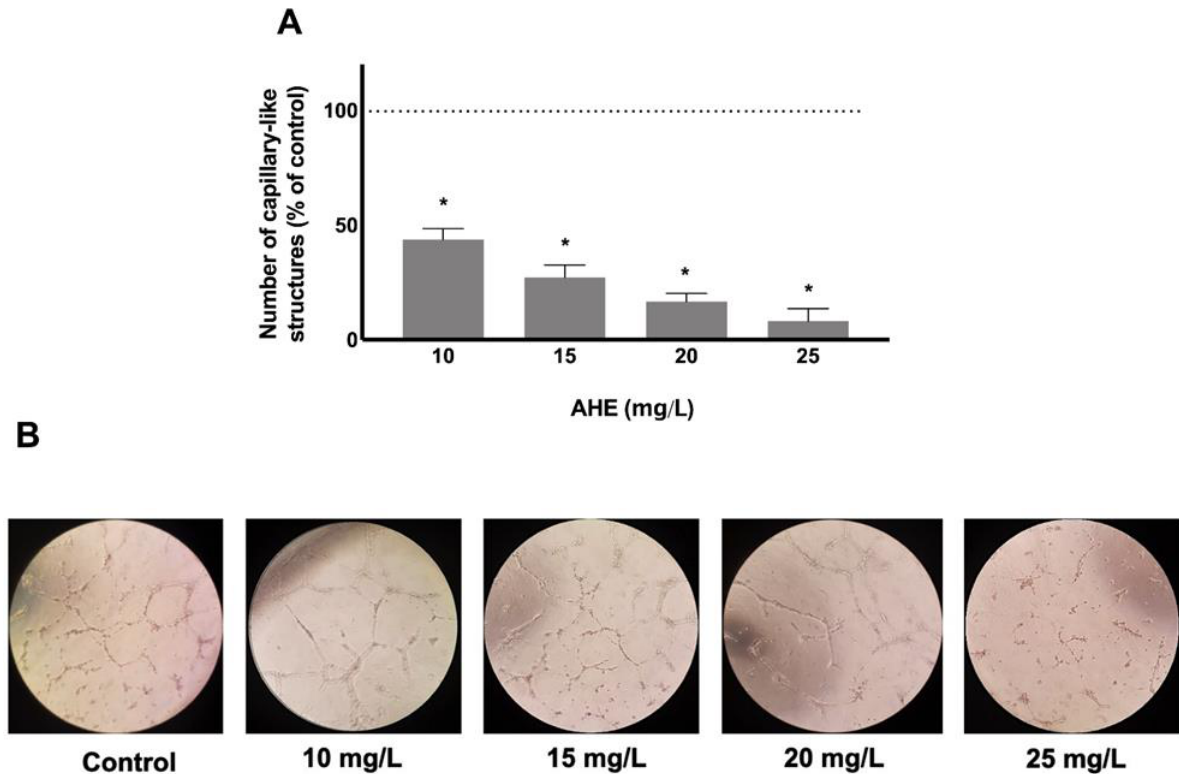
Figure 4. Formation of capillary-like structures was quantified in HMEC-1 after treatment with AHE or control, by Matrigel assay. HMEC-1 reduces, dose-dependently, its ability to assemble into tubular structures in concentrations ranging from 10 to 25 mg/L ( A ). Representative images of endothelial assembly after 16 h of standard treatments. ( B ) Results are expressed as % of control group. * p < 0.05 vs. control.